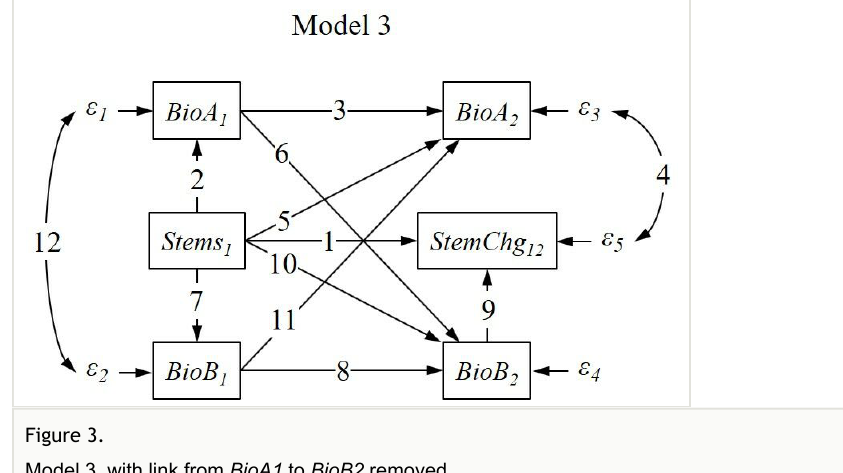
Figure 3. Model 3, with link from BioA1 to BioB2 removed.